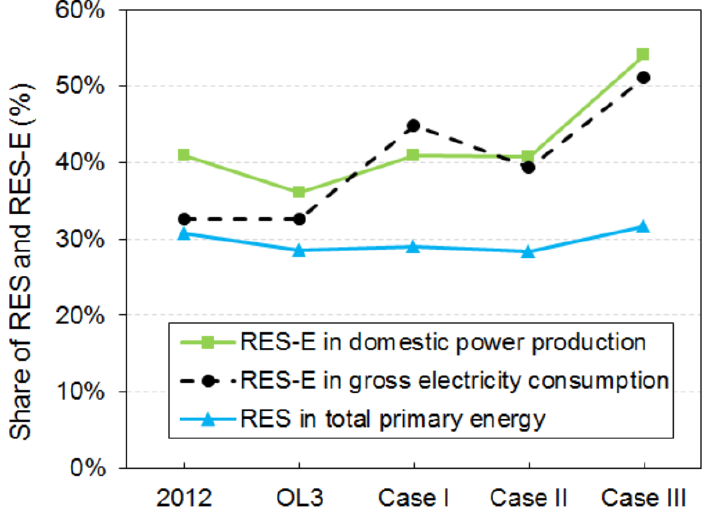
Figure 9. Share of RES and RES-E in different Cases compared to 2012, based on the assumptions in Table 3 (OL3: Olkiluoto